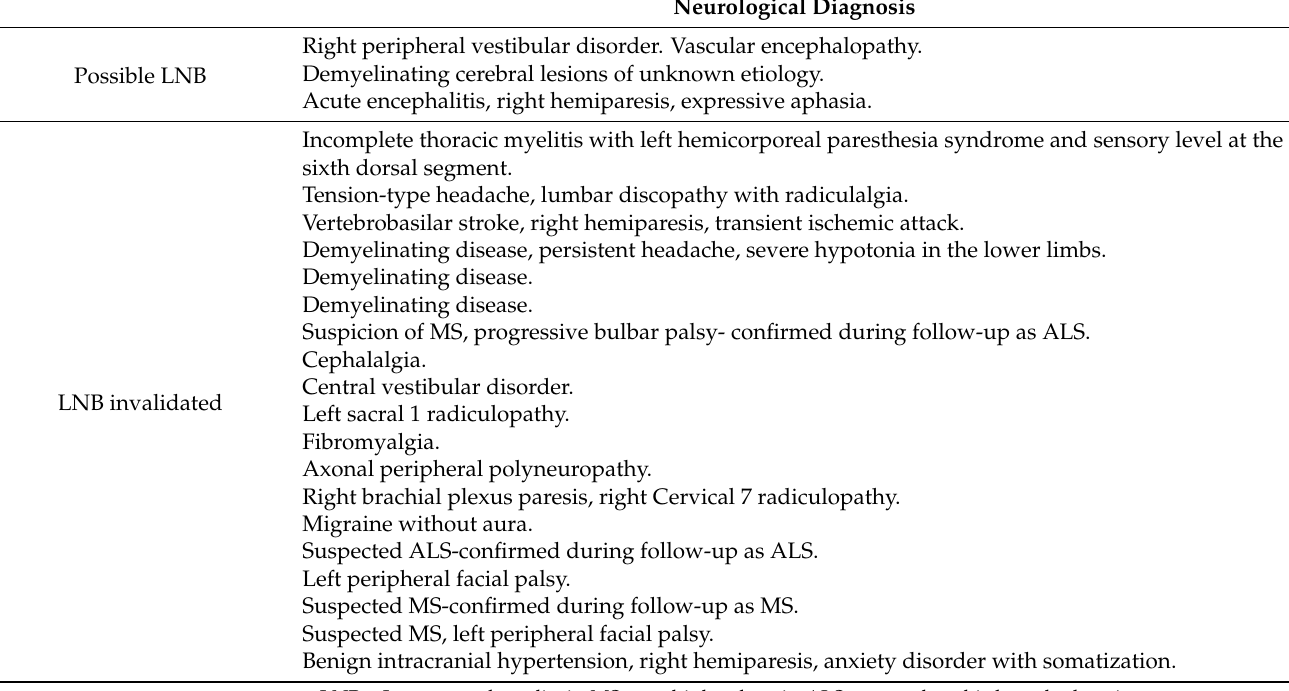
Table 4. The neurological diagnosis in 22 of the studied patients. Neurological